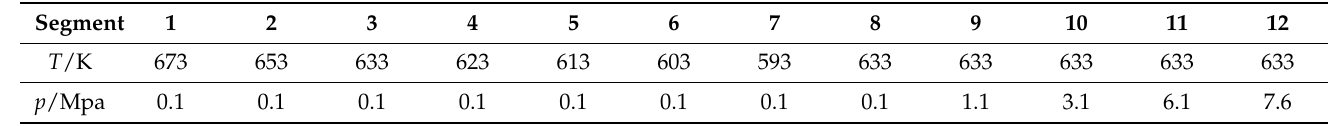
Table 2. Reaction conditions for catalytic experiments of two 1.2 wt.% Ru/C12A7e − catalysts based on plasma synthesized C12A7e − , (g) Ru/C12A7e − (5Al) and (h) Ru/C12A7e − (20Al).